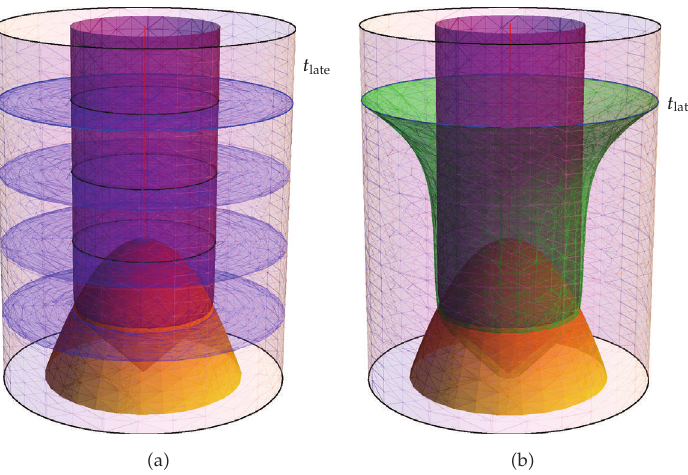
Figure 13: Possible spacelike foliations of a geometry of a black hole collapse. The outer cylinder represents the AdS boundary, the bottom (cid:3) orange (cid:4) surface a collapsing star, the (cid:3) red (cid:4) vertical line the curvature singularity, and the inner (cid:3) purple (cid:4) cylinder the event horizon. Two distinct sets of foliations are sketched. On (cid:3) a (cid:4) , the corresponding apparent horizon has settled down at late time t late (cid:3) indicated in blue (cid:4) . On (cid:3) b (cid:4) , the spacelike surface (cid:3) green (cid:4) at t late admits no apparent horizon at all.